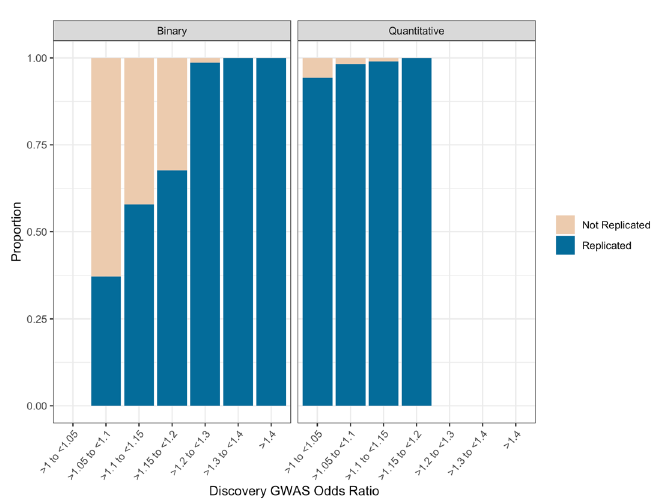
Figure 4. Replication of SNVs across odds ratios between Binary and Quantitative